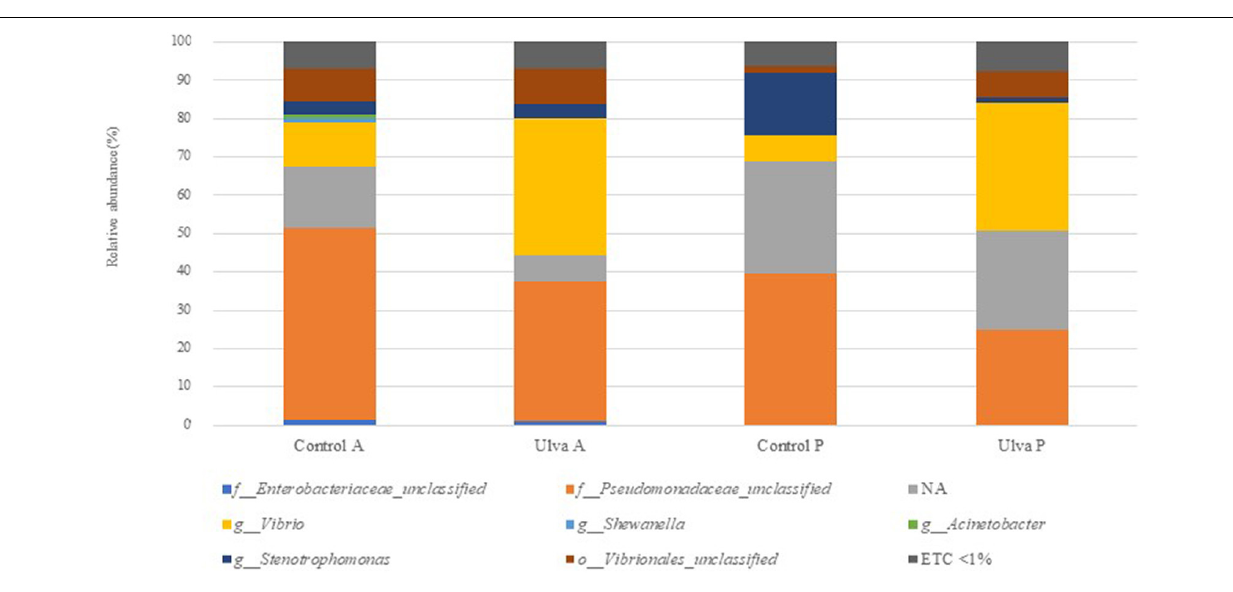
FIGURE 4 | Average of the samples of gut microbiota (relative OTU composition) at genus level of the gastrointestinal tract of S. senegalensis fed control (Control) and Ulva ohnoi supplemented (Ulva) diet for 90 days. A, anterior section; P, posterior section. NA: OTUs not clustered with the database at the genus level. ETC < 1% indicates relative abundance below